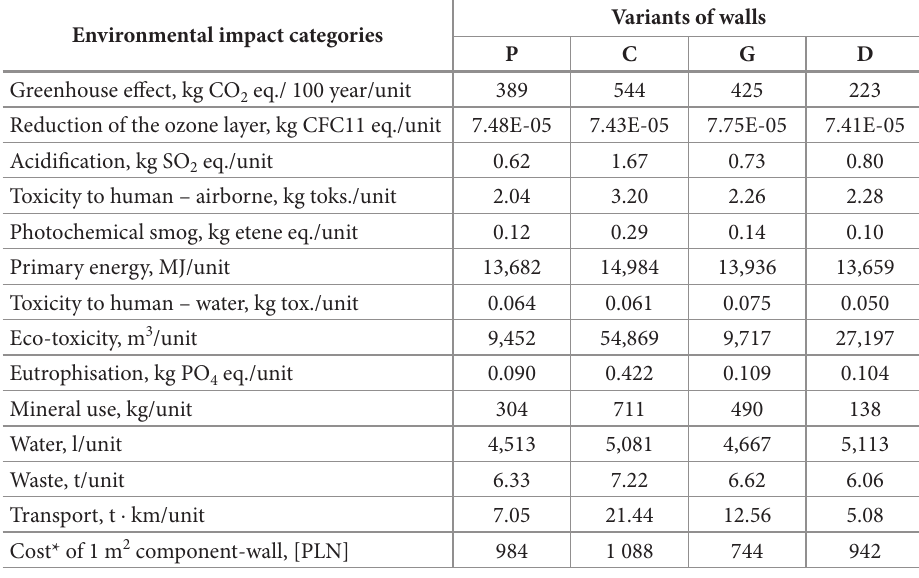
Table 2. Values of environmental impact vectors in the whole life cycle of a wall per 1m 2